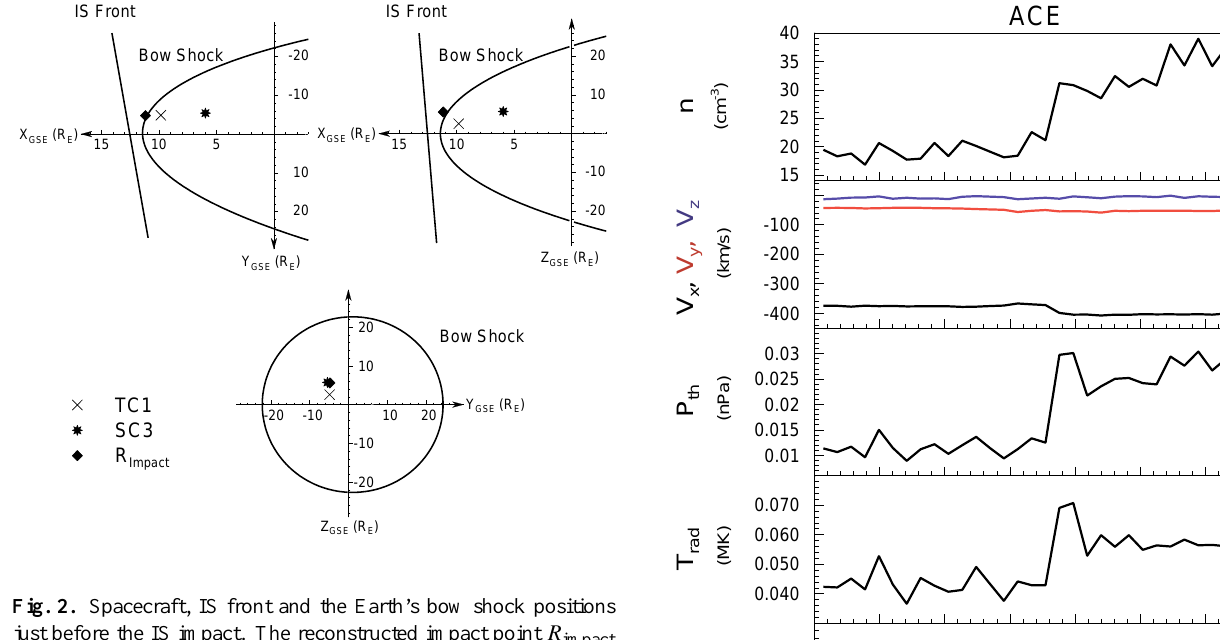
Fig. 2. Spacecraft, IS front and the Earth’s bow shock positions just before the IS impact. The reconstructed impact point R impact is also drawn. The model bow shock location (by Formisano, 1979) has been calculated using the pre-IS solar wind dynamical pressure %V 2 = 4 . 7nPa and the alfv´enic Mach number M A = 7 . 4.